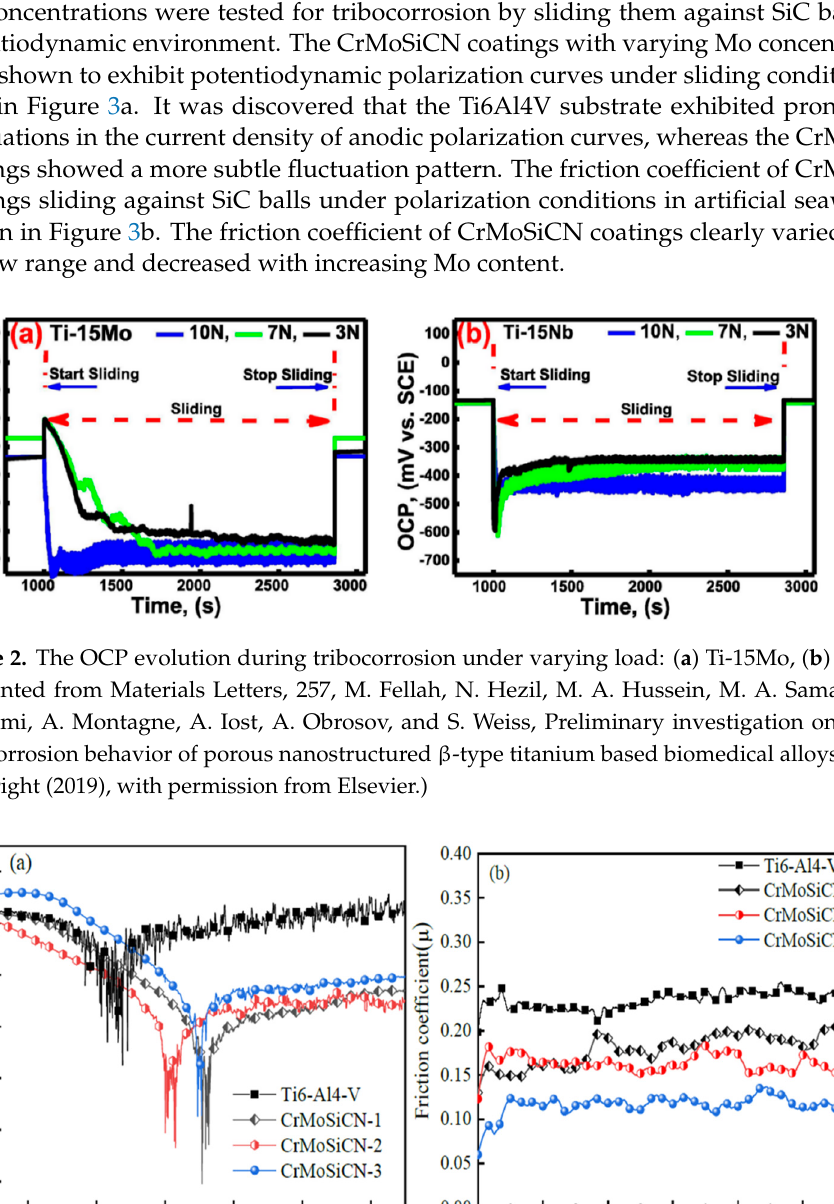
Figure 2. The OCP evolution during tribocorrosion under varying load: ( a ) Ti-15Mo, ( b ) Ti-15Nb. (Reprinted from Materials Letters, 257, M. Fellah, N. Hezil, M. A. Hussein, M. A. Samad, M. Z. Tou- hami, A. Montagne, A. Iost, A. Obrosov, and S. Weiss, Preliminary investigation on the bio-tribocor- rosion behavior of porous nanostructured β -type titanium based biomedical alloys, 126755, Copy- right (2019), with permission from Elsevier.)